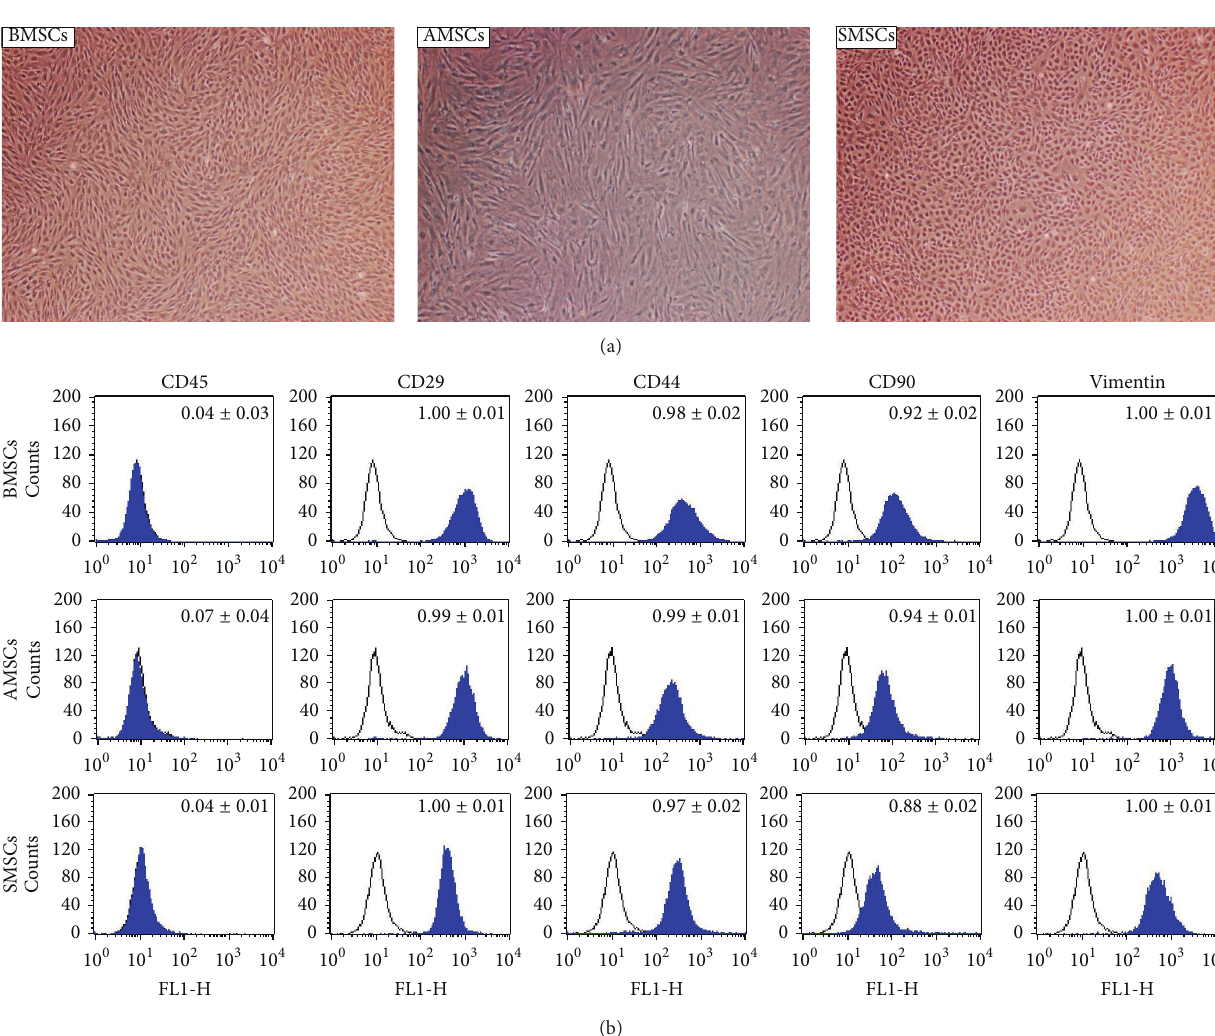
Figure 1: Morphology of MSCs and cell surface antigen expression. BMSCs, AMSCs, and SMSCs were cultured in separate 35 mm dishes and displayed the morphology at 4 passages in phase contrast images (a). Three kinds of MSCs were analyzed for MSCs specific surface antigen expression by flow cytometry (b). Open histograms imply isotype IgG expression as control, and filled histograms represent each surface antigen expression. Mean% ± SD of each MSCs expression in respective three biological replications was presented on top of each graph. BMSCs: bone marrow derived mesenchymal stem cells; AMSCs: adipose derived mesenchymal stem cells; SMSCs: skin derived mesenchymal stem cells. Magnification ×